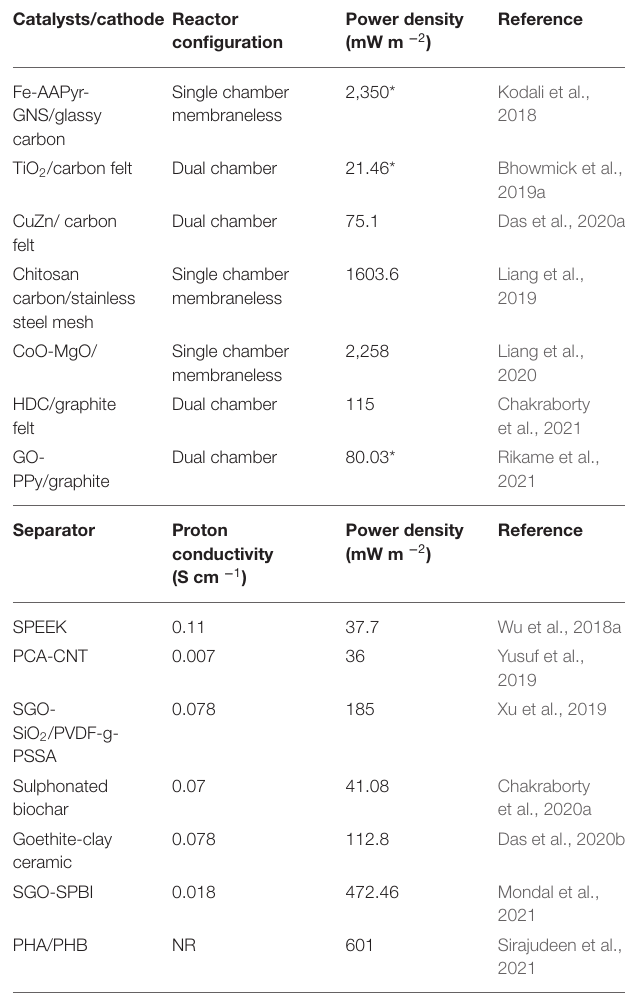
TABLE 2 | Power density obtained using different cathode catalysts and separators in